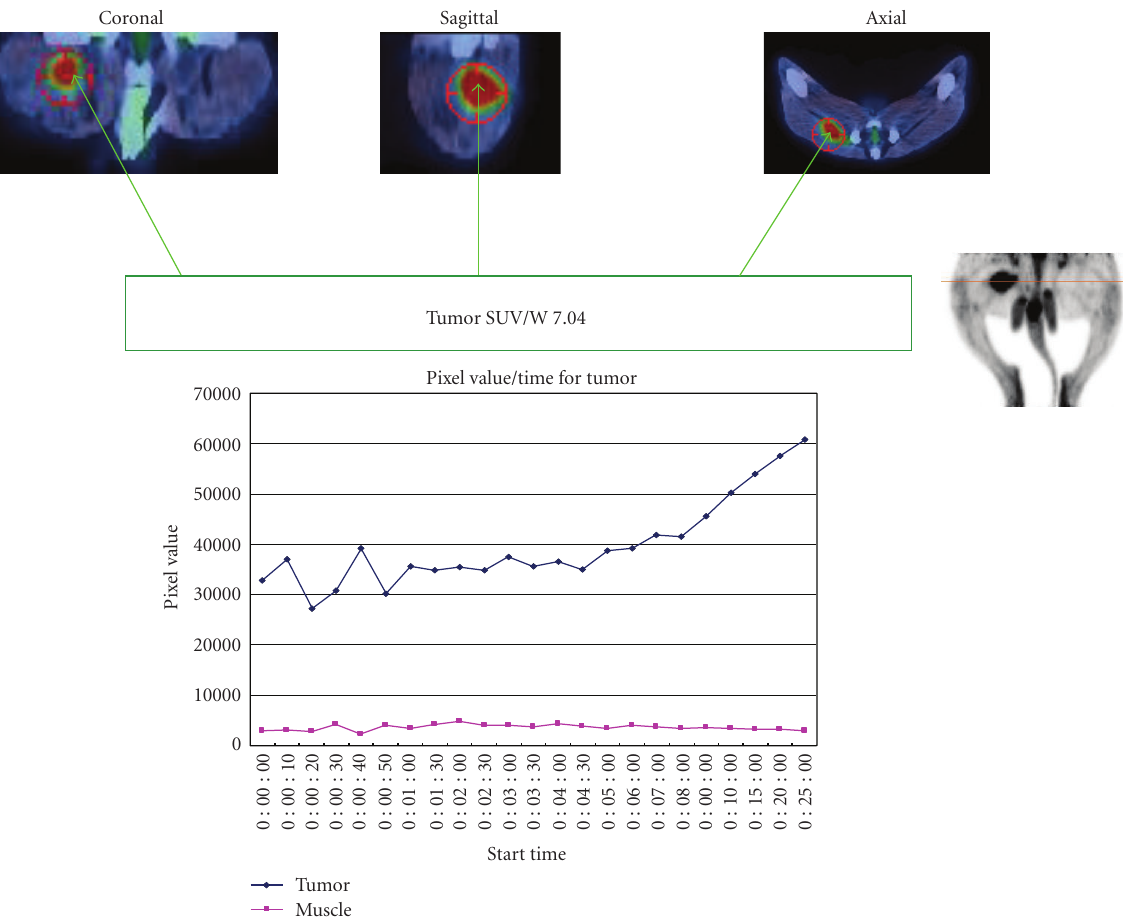
Figure 8: 45 minutes dynamic image with PET-CT of 18 FDG in New Zealand white rabbit bearing VX2 tumor showed SUV of the tumor was